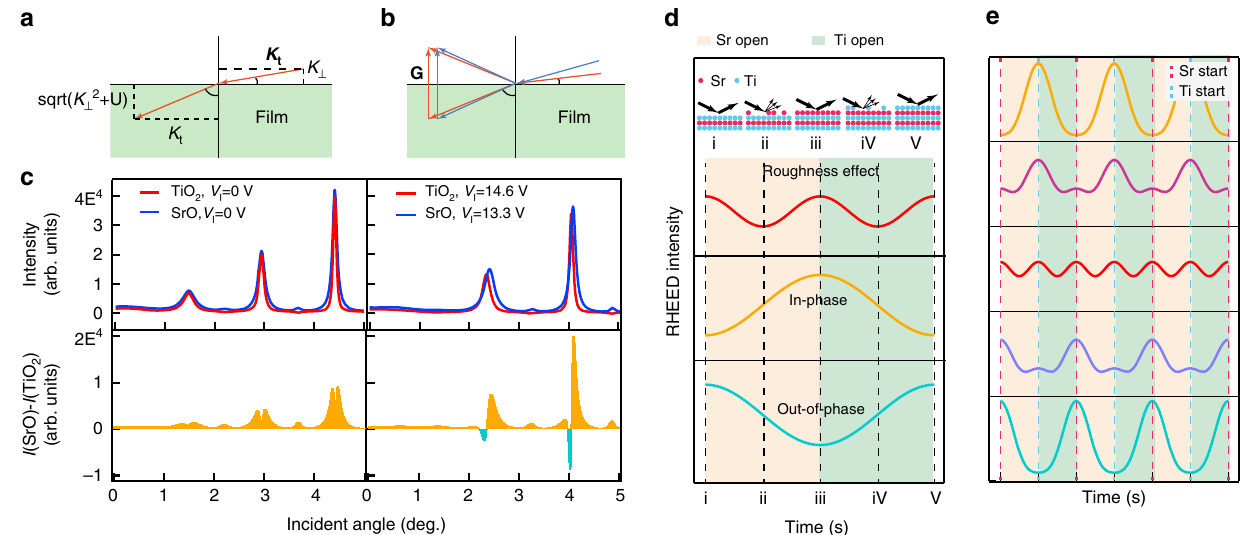
Fig. 3 Origin of RHEED oscillations. a The mean inner potential results in an increase of the component of the electron momentum that is perpendicular to the fi lm surface. b Higher mean inner potential (blue lines) will decrease the incident angle that satisfy the Bragg diffraction condition. c The calculated electron diffraction intensity as a function of incident angle shows a strong dependance on the mean inner potential. For simplicity, when SrO (TiO 2 ) termination yields stronger diffaction intensity, it is called the in-phase (out-of-phase) condition. d Schematic of three extreme cases of RHEED oscillations that include only periodic surface roughing, pure in-phase, and pure out-of-phase oscillations. e Simulated RHEED oscillations calculated by combining the three extreme case components shown in panel ( d ) with different weighting factors to simulate the incident angle dependence of the electron